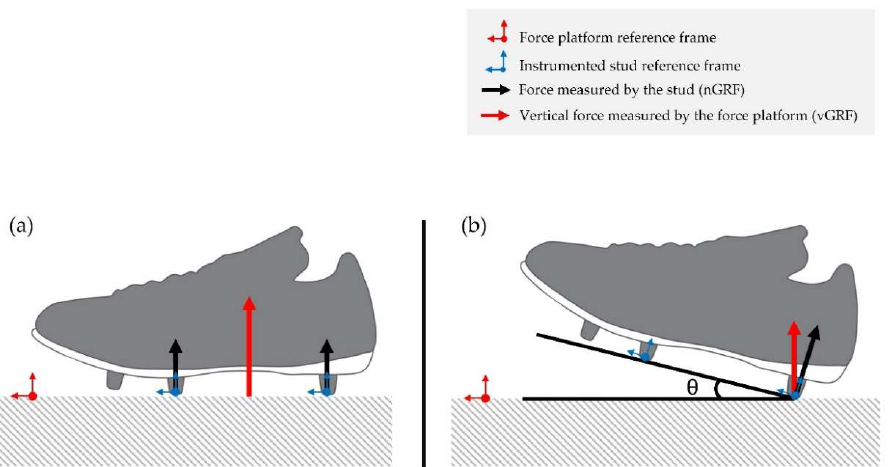
Figure 4. Schematic representation of the forces measured by the instrumented shoe (IS) and the force platform (FP) and their associated reference frames. ( a ) Case where nGRF would be equal to vGRF. ( b ) Case where nGRF would be different to vGRF due to a θ angle at ground strike (adapted from Oudshoorn et al., 2018 [45]).